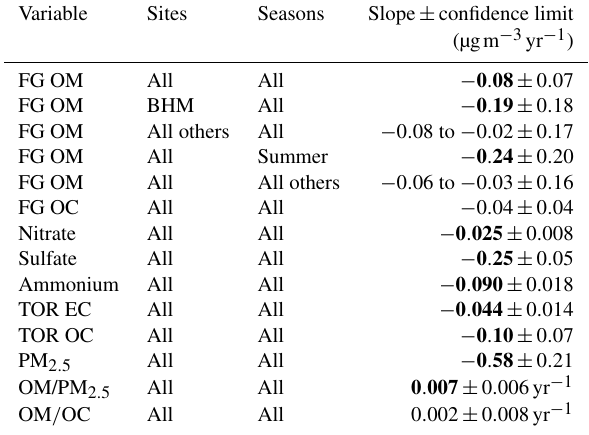
Table 1. Trends in variables measured using FT-IR spectrometry. Slopes were calculated using Theil–Sen regression for data between 2011 and 2016 (Sect. 2.8). For FG OM and FG OC, the seasons and sites with the most extreme slopes are shown separately from “all others”. Confidence limits were bootstrapped at 95% confidence. Slope values in bold are greater than the confidence limits. Note that units for OM / PM 2 . 5 and OM / OC trends are yr − 1